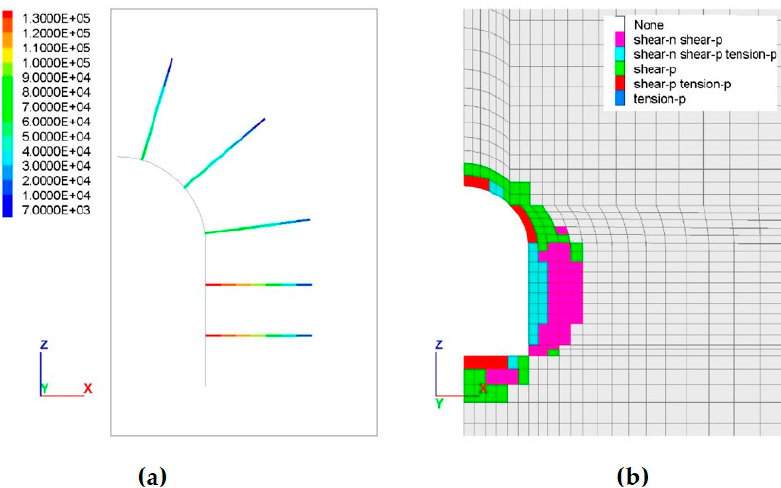
Figure 6. Transversal tunnels in shale formation: ( a ) rock bolts axial force [N]; ( b ) state of plasticity.